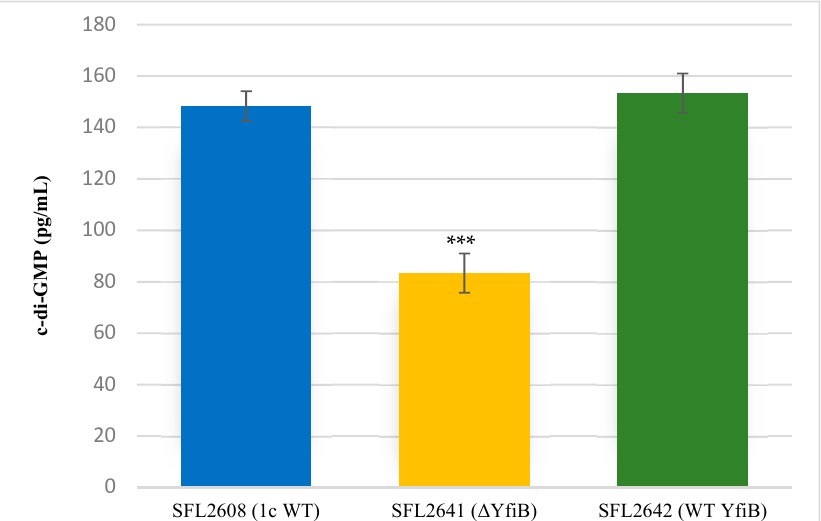
Figure 2. Quantification of intracellular c-di-GMP levels. Bar graph showing the levels of native c-di-GMP for S. flexneri strains: 1c wild-type (SFL2608), yfiB KO mutant SFL2641 ( ∆ YfiB), yfiB-complemented strain SFL2642 (YfiBComp). The c-di-GMP concentration was analysed using a Cyclic-di-GMP ELISA kit by Cayman Chemicals. The calculations are based on a standard curve for c-di-GMP and assaying each sample in duplicates. Statistically significant variance is denoted by asterisks (*** = p value < 0.001). The standard deviation of data from three autonomous experiments is depicted by the error bars.